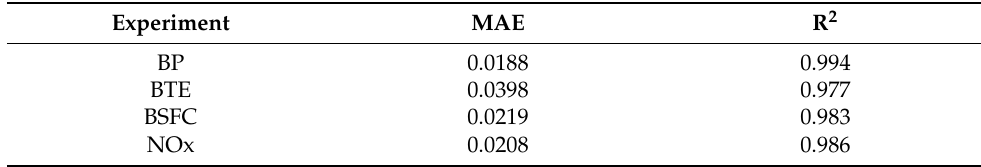
Table 3. Multivariate polynomial regression evaluation.